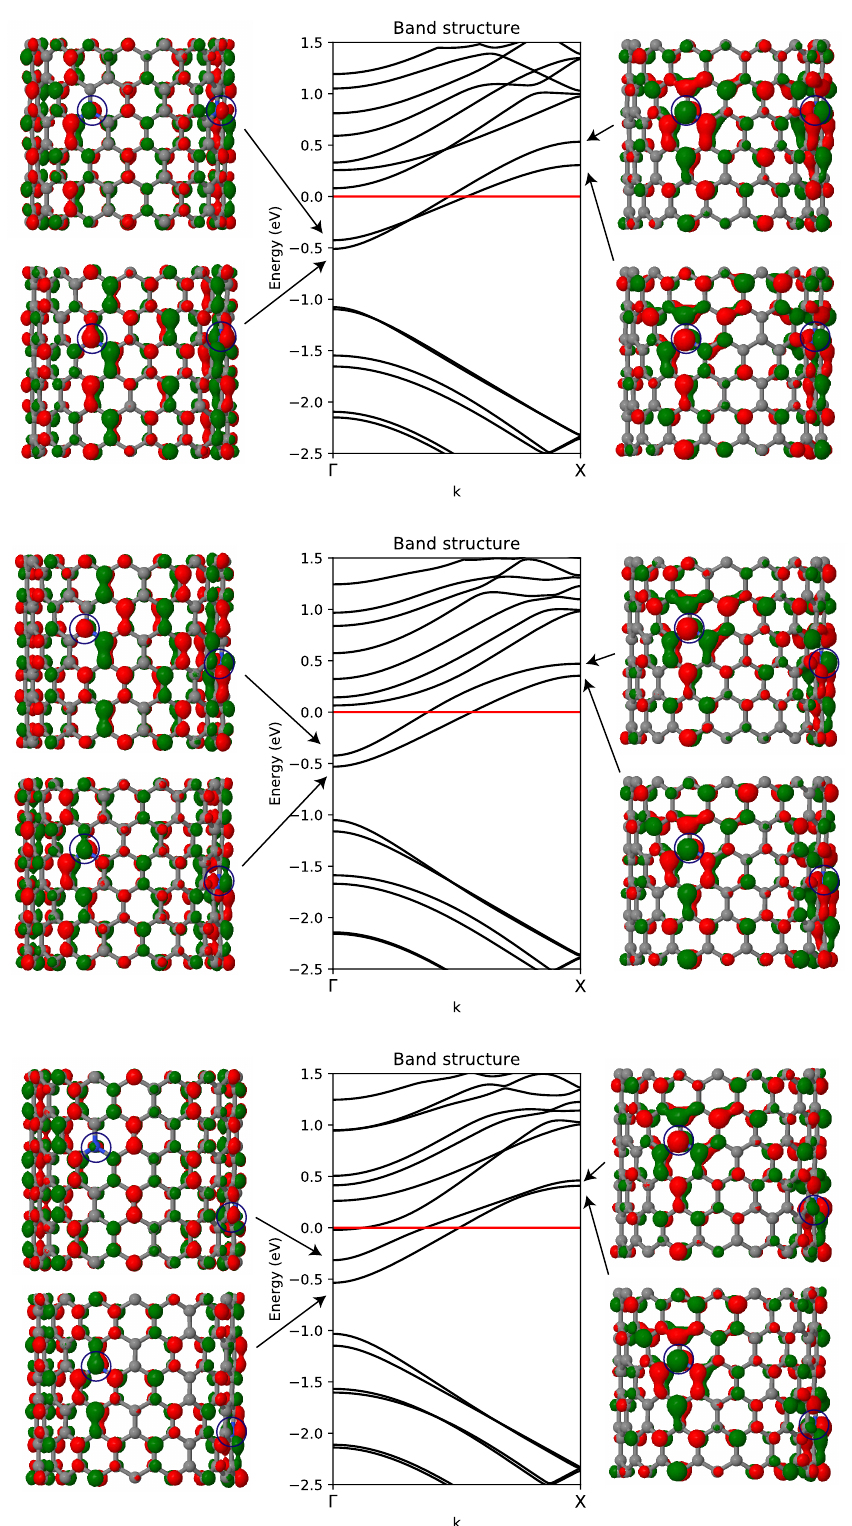
Figure 4. Electronic band structures of N-CNT systems A8 ( σ rel = 2.11), B9 ( σ rel = 2.28), and C10 ( σ rel = 2.35). The location of the two nitrogen dopants is illustrated with blue circles. The crystalline orbitals associated with two bands crossing the Fermi level are shown at Γ and X points, the latter point corresponding to the boundary of the first Brillouin zone at π /2. Isodensity value of 0.02 a.u. was used to plot the crystalline